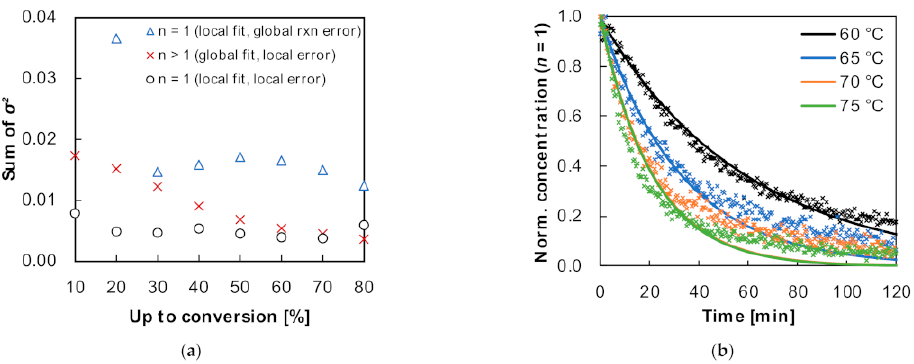
Figure 5. ( a ) Plot of the respective fit errors for the fit of all conversion curves or concentration profiles according to reaction order n = 1 and n > 1 up to a certain conversion. The local error describes the error in the respective conversion range, the global error includes all measuring points of the